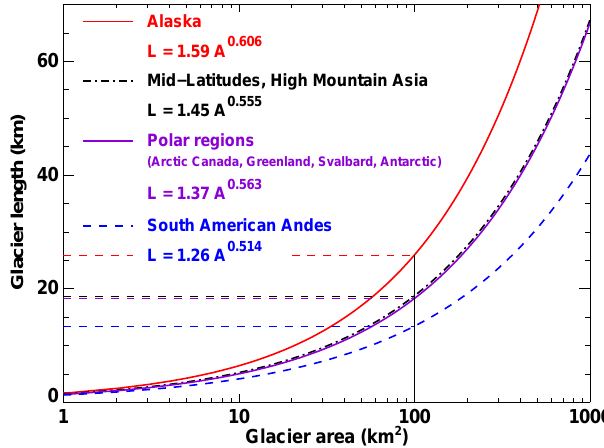
Figure 10. Scaling relationships between glacier area A and length L derived for four subsets of glacier regions. The scaling parameters are given, and a reading example for a glacier with A = 100km 2 is